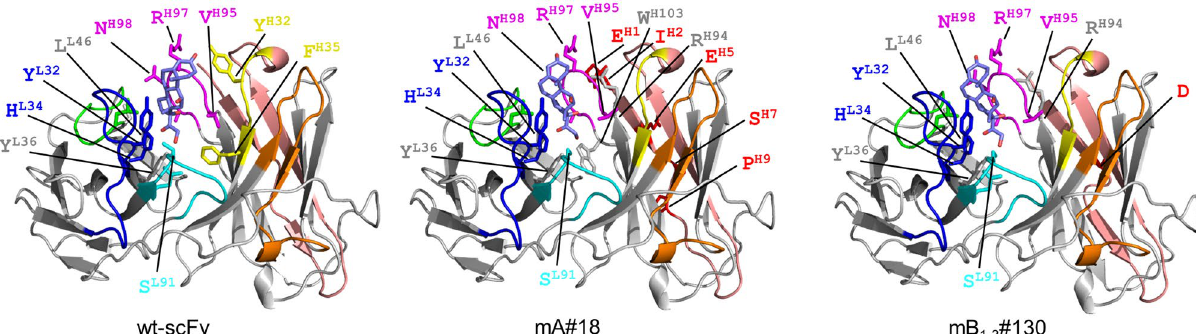
Figure 4. Protein ribbon structures of wt-scFv, mutant scFvs mA#18 and mB 1-3 #130 were constructed using the SWISS-MODEL Protein Modelling Server 43 , and their conformations when docked to cortisol were predicted using SwissDock 44 . The V H -CDR1 (yellow), V H -CDR2 (orange), V H -CDR3 (magenta), V L -CDR1 (dark blue), V L -CDR2 (light green), and V L -CDR3 (light blue) are shown with β-sheet structures (bold gray arrows). The amino acid residues that are close to cortisol (< 4 Å), and the substituted and inserted amino acids in